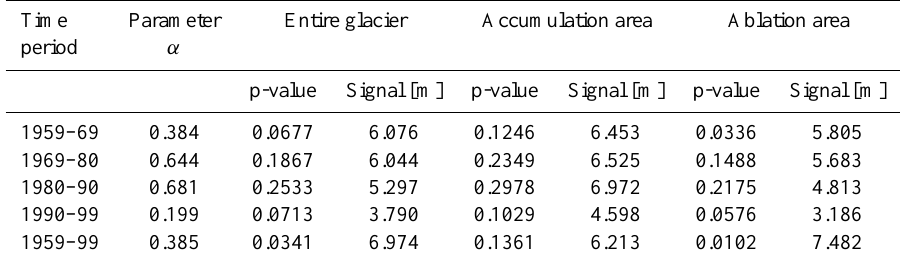
Table 4. Statistical analysis of the Monte-Carlo Simulation. The p-values show the probability that random error in the DEMs and the calculated thickness changes (signal) are equal. The results are separated into entire glacier, accumulation area, and ablation area. For details see text.